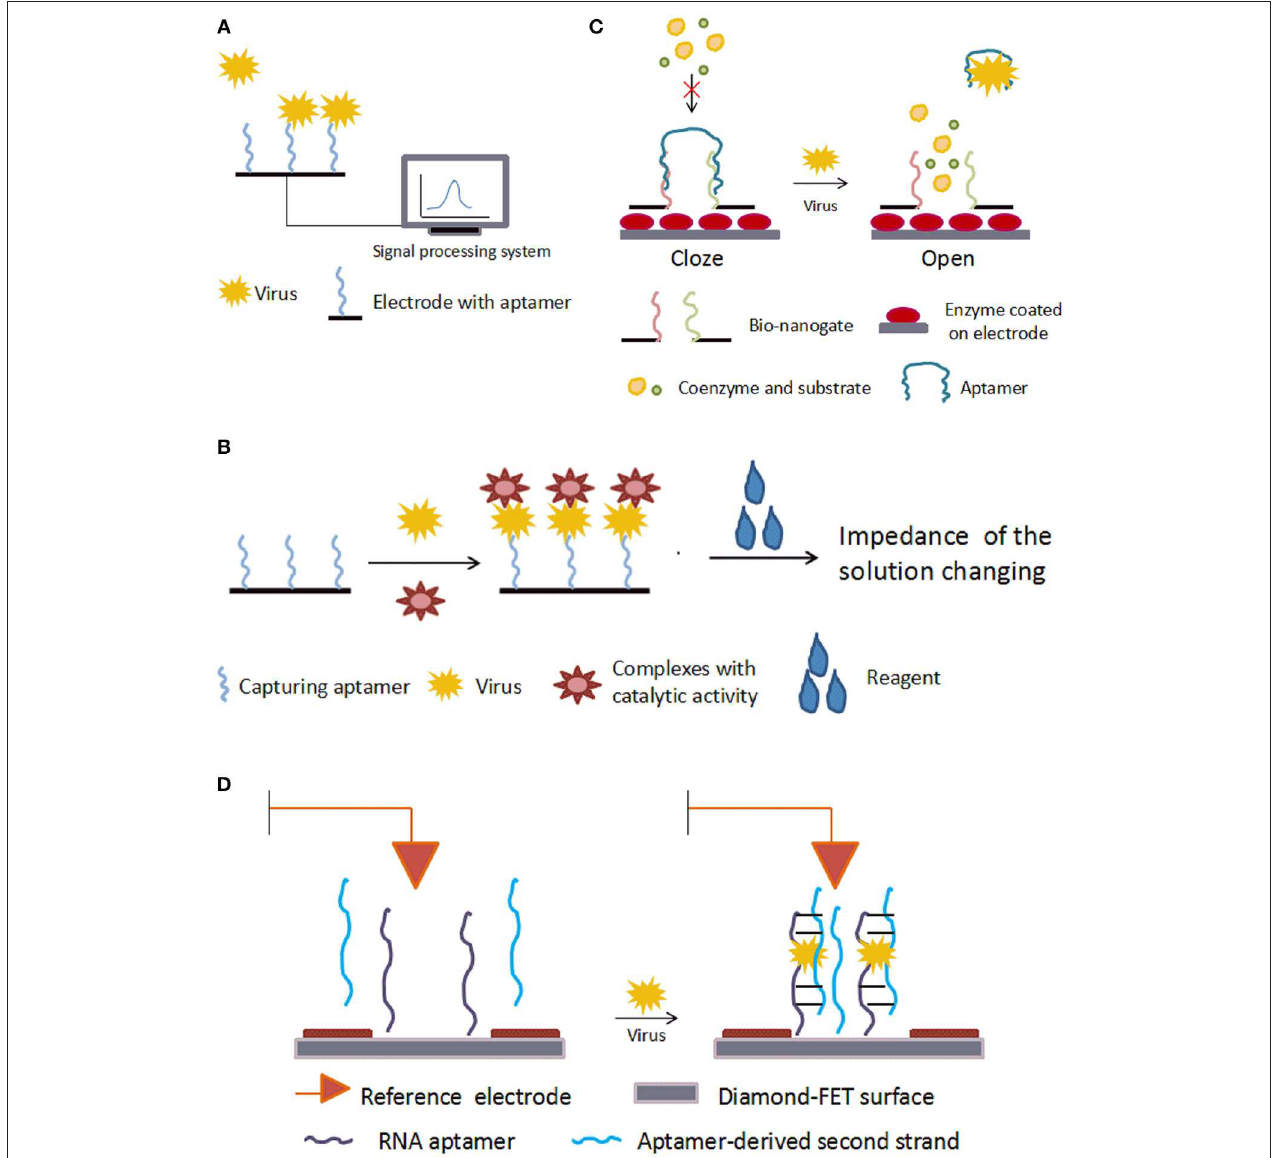
FIGURE 3 | Schematic illustration of electrical aptasensors. (A) Mechanism of typical electrochemical aptasensor without enzymes. The combination of aptamer and target virus changes the electrical signal on the electrode. (B) Mechanism of electrochemical aptasensor with enzymes. (C) Mechanism of a nanogate. With no target virus, the aptamer binds the bio-nanogate to close the “door” and keep the enzyme away from the coenzyme and substrate. The target virus can grab the aptamer from the nanogate, and the enzyme on the electrode reacts with the coenzyme and substrate, leading to a change in the electrical signal on the electrode. (D) Mechanism of a diamond-aptamer FET sensor. The aptamer probe is on the diamond-FET surface. In the presence of virus, the aptamer captures the virus and forms a complex with a second aptamer strand. This causes changes in the electric charges on the surface, which is sensed by the